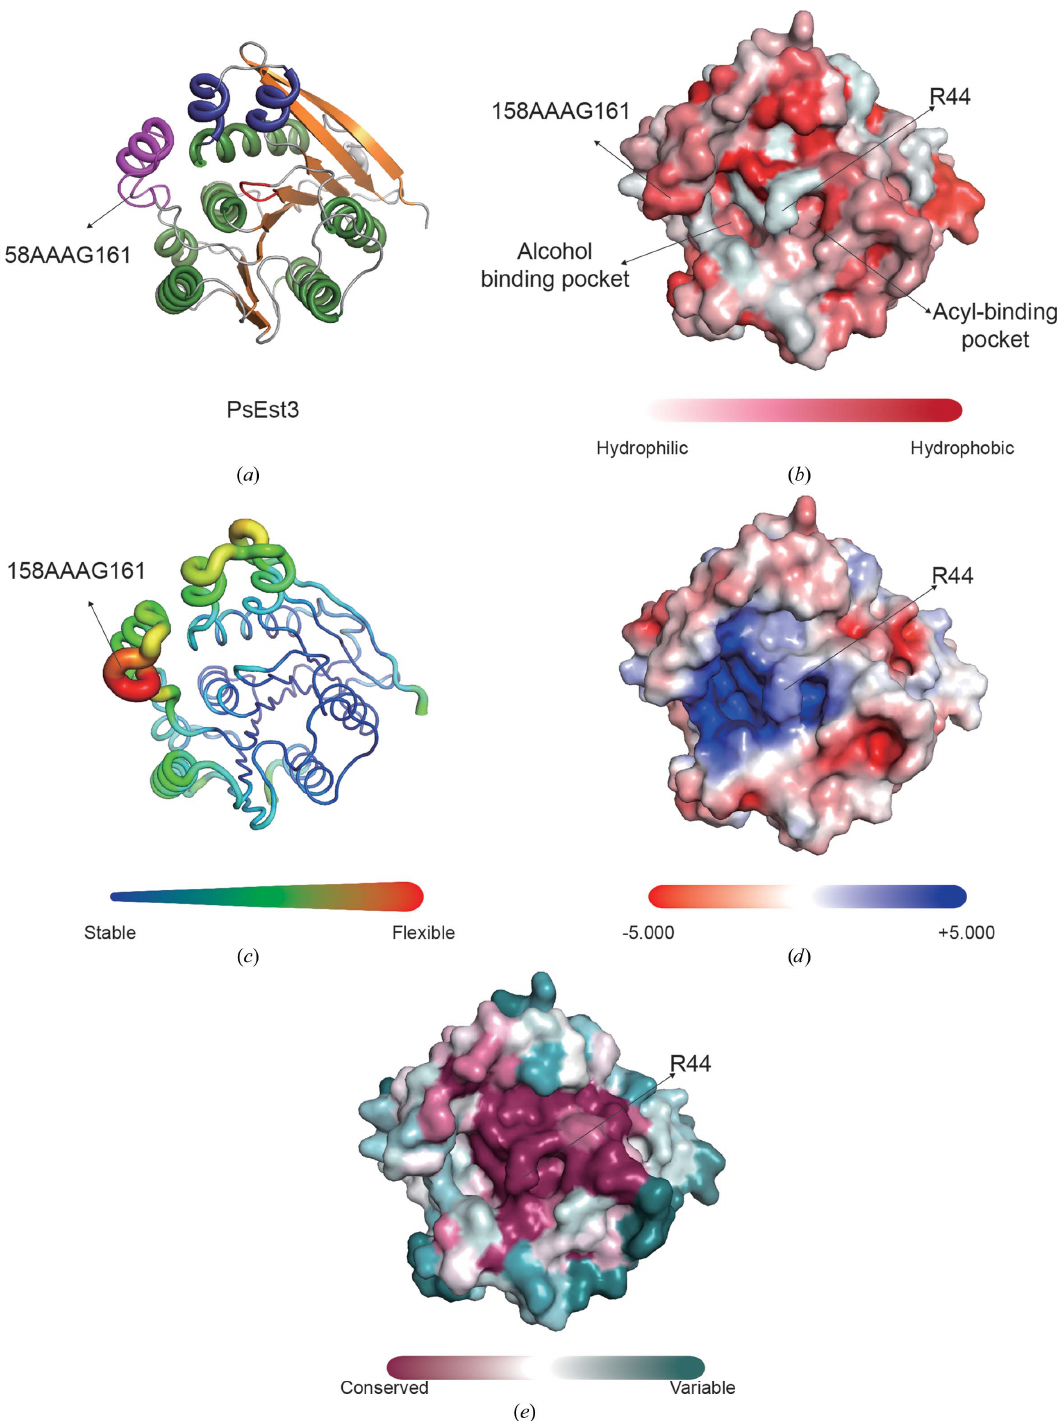
Figure 2 Analysis of the surface characteristics of PsEst3. ( a ) Cartoon representation of the malonate-bound structure of PsEst3. The overall color scheme is identical to that in Fig. 1( a ). ( b ) Hydrophobicity of the PsEst3 surface. ( c ) B -factor distribution of PsEst3. ( d ) Electrostatic potential of the PsEst3 surface. ( e ) The degree of conservation of PsEst3 residues is represented as a surface model. The degree of conservation was calculated with 250 homologs based on BLAST results using the UniProt database. The color gradient of the degree of conservation progresses from magenta to